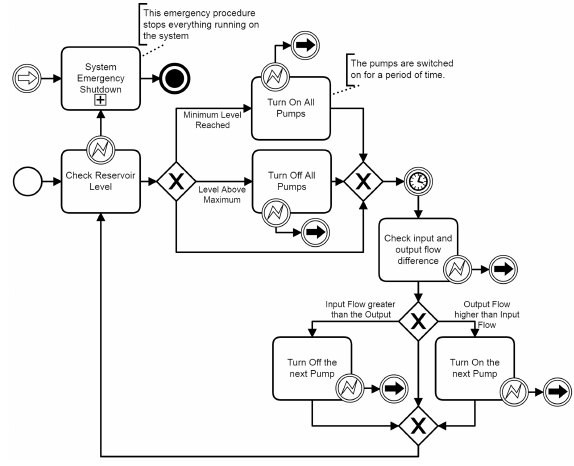
Figure 3. Water supply process depicted in Business Process Model and Notation (BPMN).